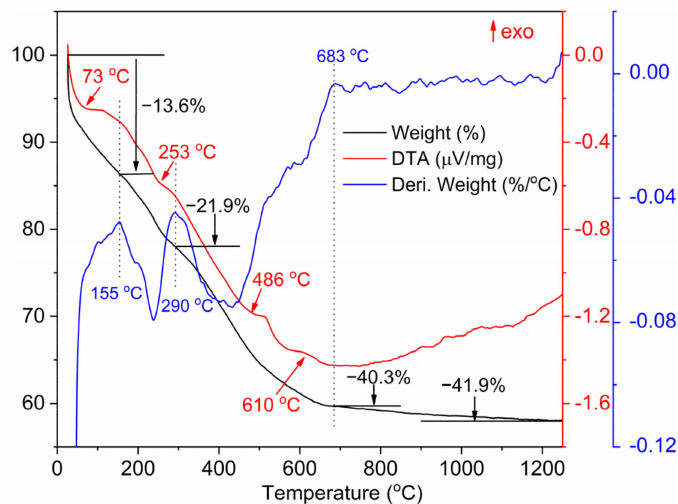
Figure 3. TG-DTA-DTG curves of the Dy 2 O 3